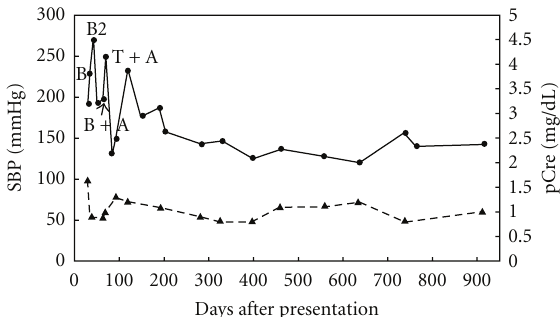
Figure 2: Changes in the systolic blood pressure (SBP; solid line) and plasma creatinine concentration (pCre; dashed line). B: benazepril (0.69mg/kg, once daily); B2: benazepril (0.69 mg/kg, twice daily); A: amlodipine (0.35mg/kg, once daily); T: temocapril (0.11mg/kg, once